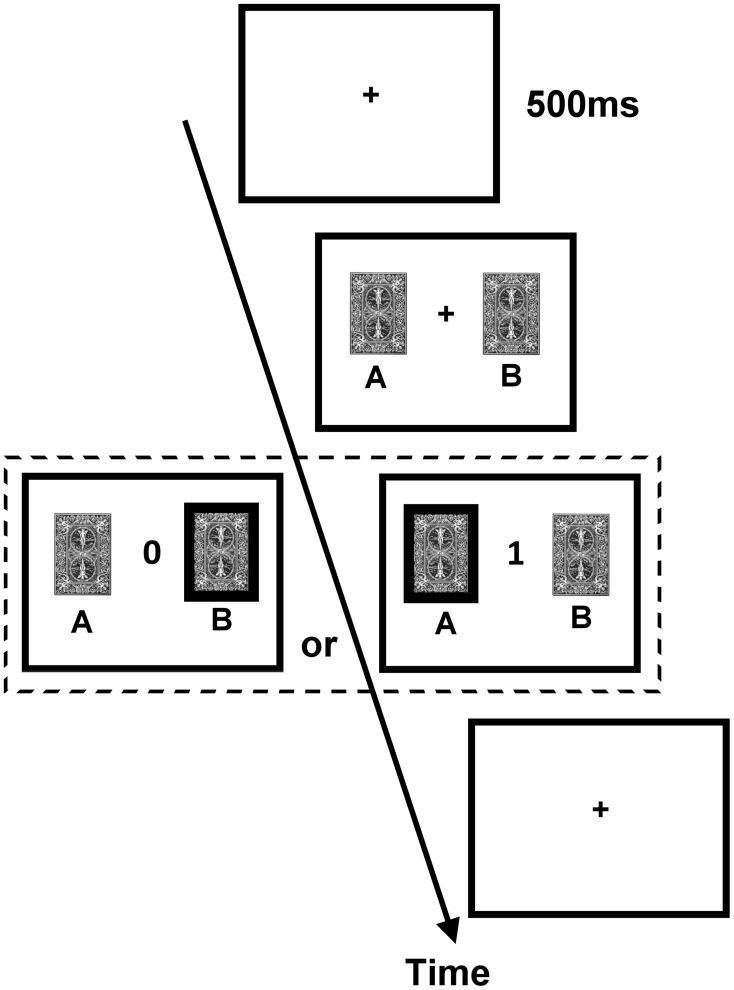
Procedure of the dynamic reward task. Each trial began with the presentation of the fixation cross (size 0.6° × 0.6° visual angle) for 500 ms. Subsequently, two identical cards (size 3.81° × 5.08° visual angle) appeared on the two sides of the fixation cross until a participant chose one card. After a card was chosen, the score of the chosen card (either 0 or 1; size 1.27° × 1.53° visual angle) was presented in the center of the screen until a participant pressed SPACE on the keyboard to end the trial and to initiate the next trial.